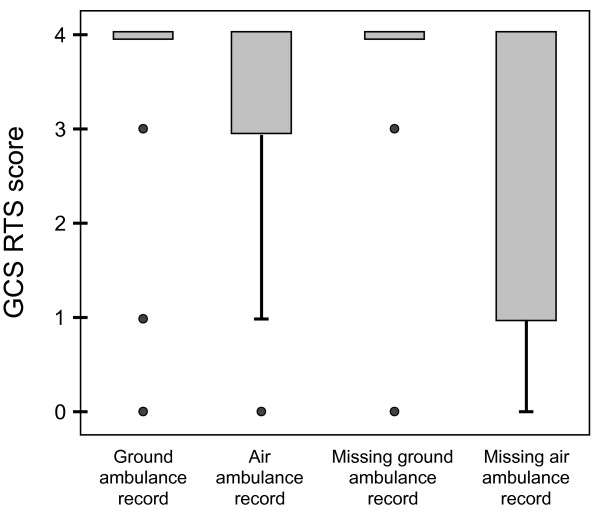
Distribution of GCS RTS score in patients transported by ground and air ambulance. Box plot of GCS RTS scores in patients from motor vehicle accidents documented in ground ambulance records (n = 231), air ambulance records (n = 75), and in-hospital arrival records where ground (n = 61) and air (n = 15) ambulance records were missing. Patients transported by air ambulance had poorer GCS RTS scores than those transported by ground. Notably, patients transported by air with missing ambulance records displayed the poorest GCS RTS scores.